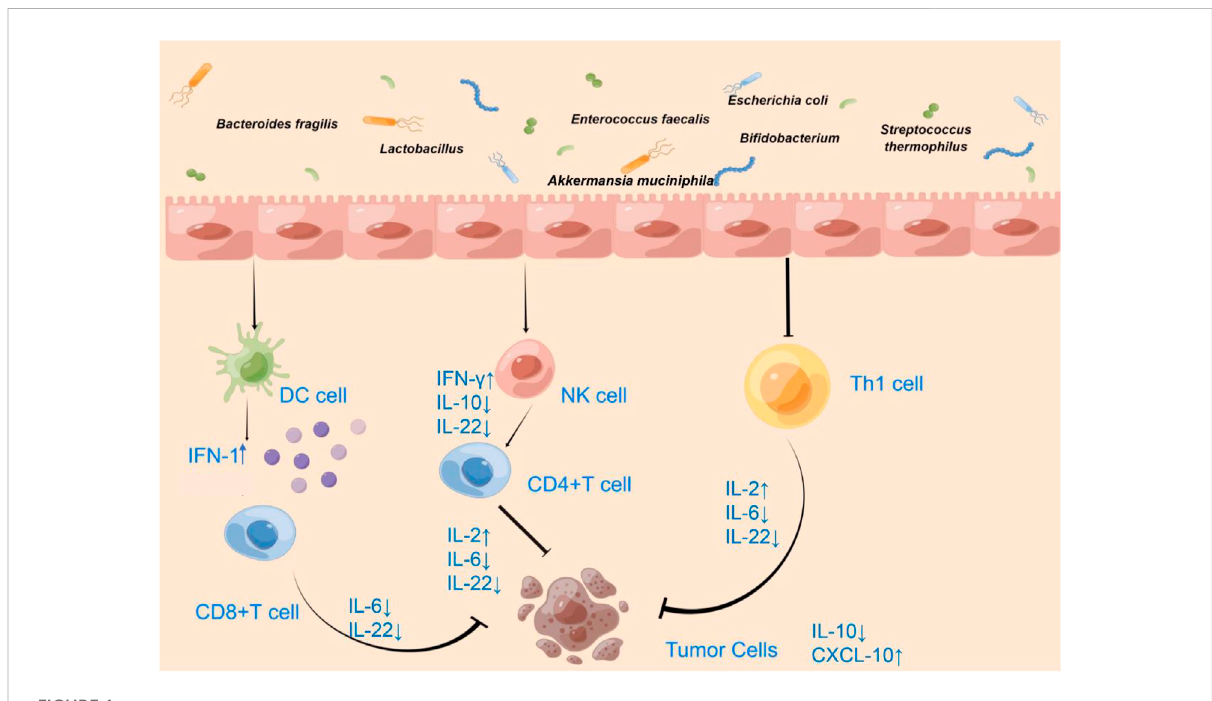
FIGURE 1 Effect of microbiota on the immune microenvironment of